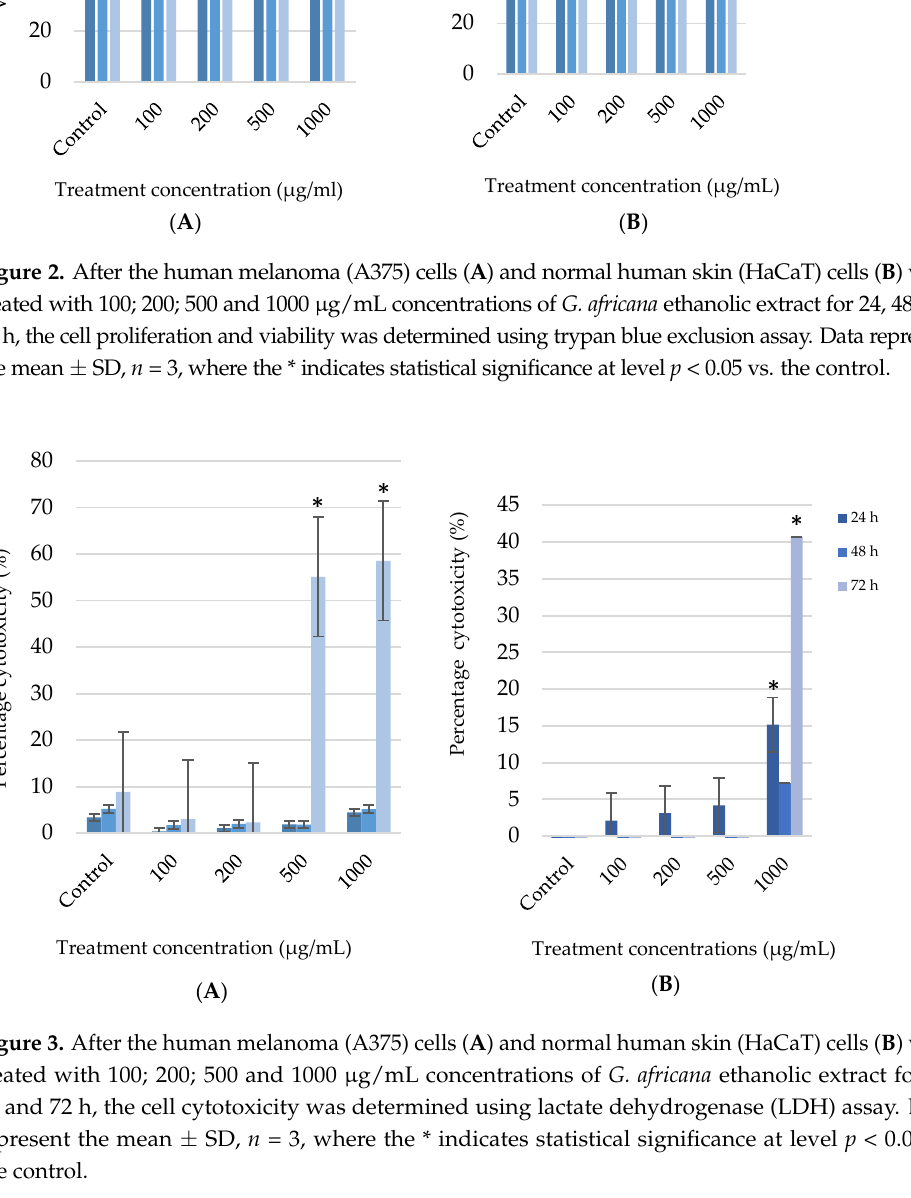
Figure 3. After the human melanoma (A375) cells ( A ) and normal human skin (HaCaT) cells ( B ) were treated with 100; 200; 500 and 1000 µg/mL concentrations of G. africana ethanolic extract for 24, 48 and 72 h, the cell cytotoxicity was determined using lactate dehydrogenase (LDH) assay.